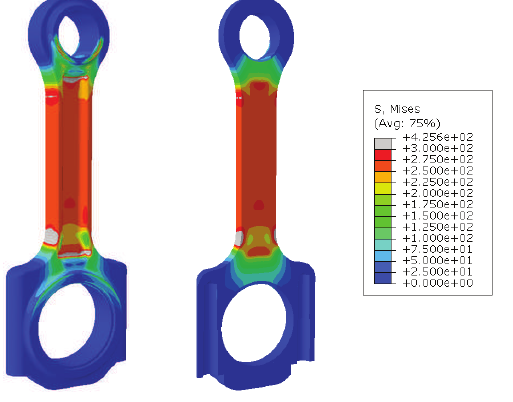
Fig. 10. Results of simulation of connecting rod model 3